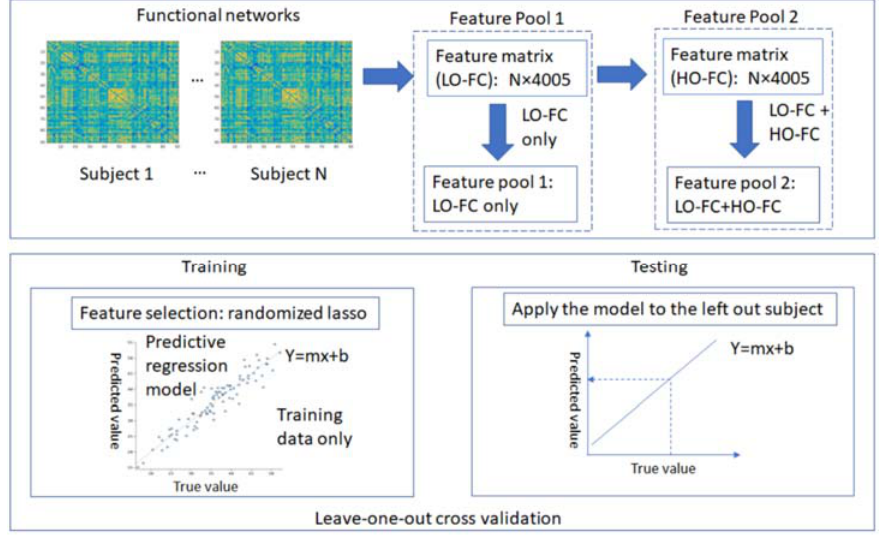
Figure 1. F low chart of the